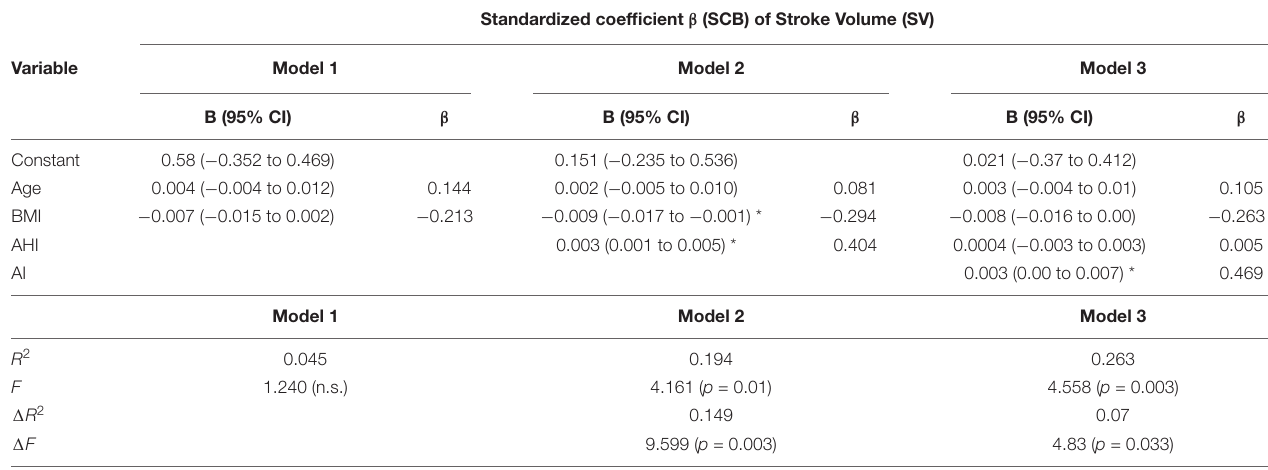
TABLE 7 | Hierarchical regression analysis of anthropometric and sleep variables for the hemodynamic standardized coefficient β prediction of stroke volume. Standardized coefficient β (SCB) of Stroke Volume